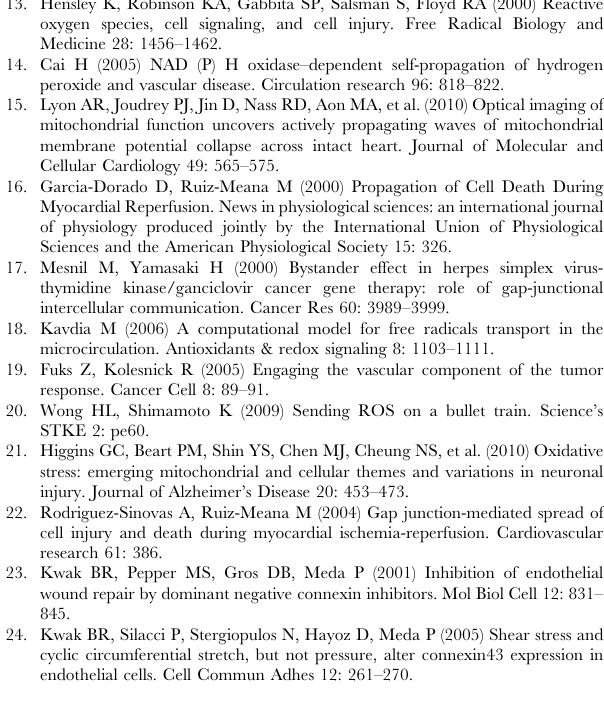
Figure S1 Illumination region accuracy control. Agar gel